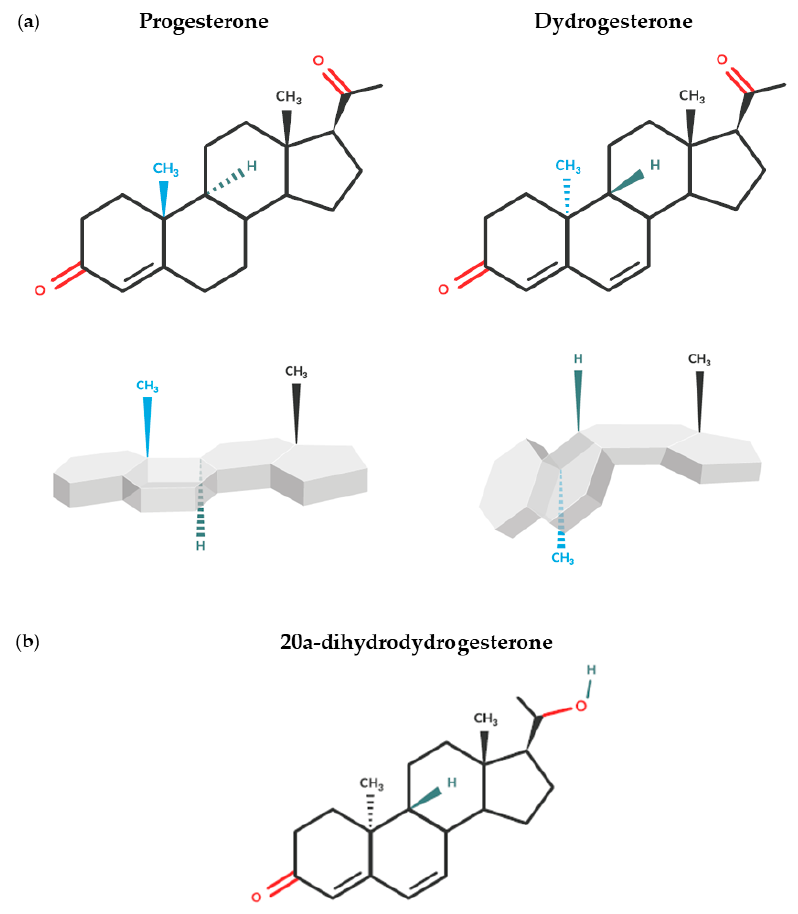
Figure 1. Chemical structures of ( a ) progesterone and dydrogesterone and resulting difference in spatial conformation and ( b ) main dydrogesterone metabolite, 20 α -dihydrodydrogesterone.